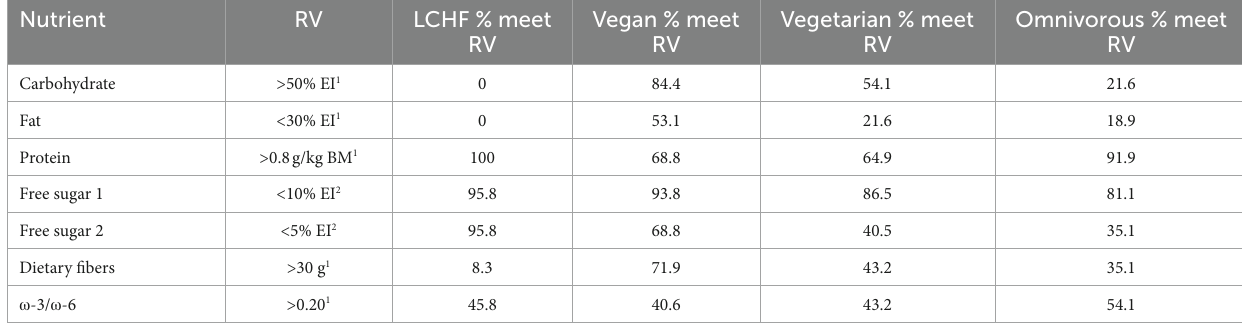
TABLE 2 Percentage of participants meeting reference value.